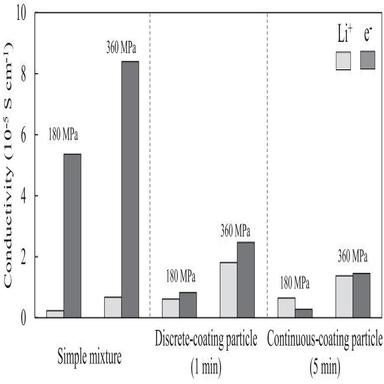
Electrical and ionic conductivities of cathode pellets prepared from the simple mixture, discrete-coating particles, and continuous-coating particles at pressures of 180 and 360 MPa.